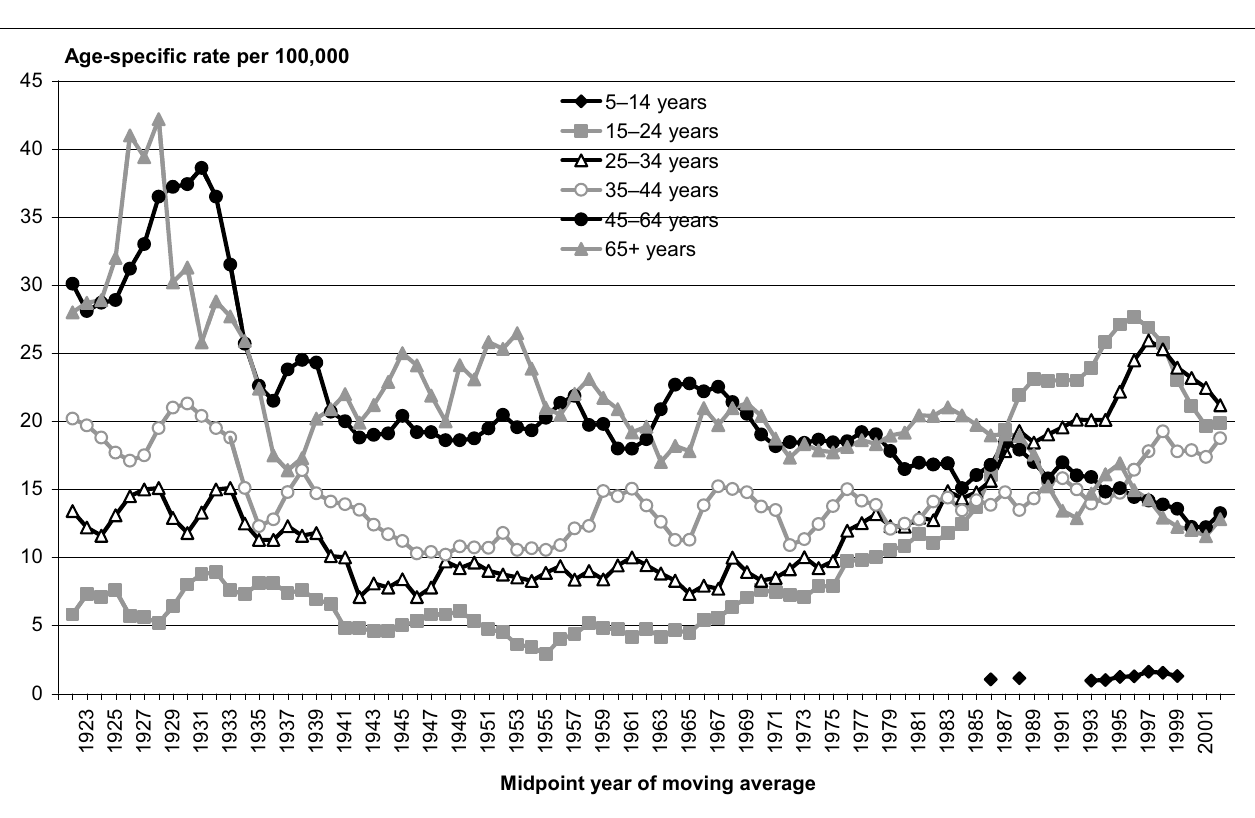
FIGURE 2 | Suicide rates by age, New Zealand 1923–2003 . Source: New Zealand Health Information